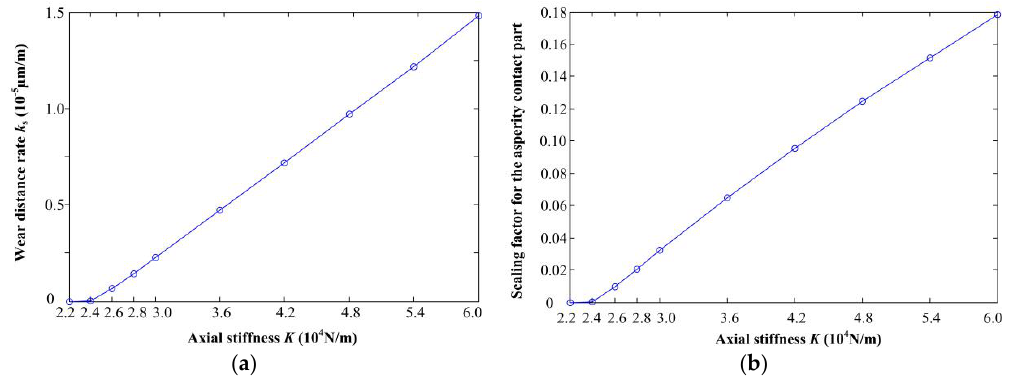
Figure 14. ( a ) Wear distance rate for different axial stiffness values; ( b ) scaling factor for the asperity contact for different axial stiffness values.